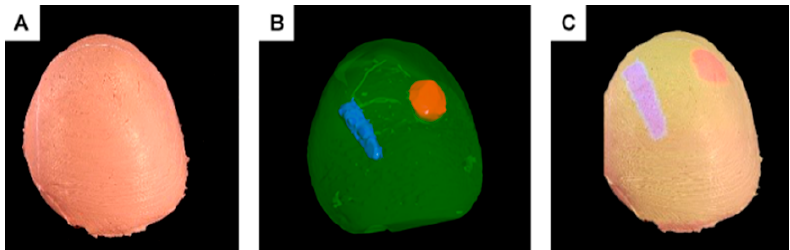
Figure 11. ( A )—Liver phantom without projection, ( B )—rendered 3D scene for current position, and ( C )—liver phantom illuminated by projector.